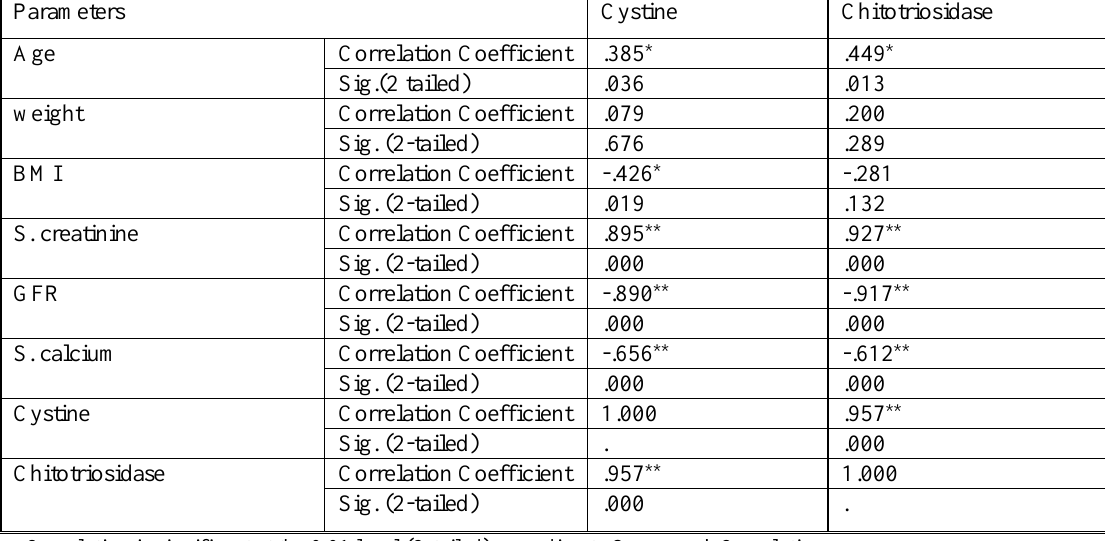
** Correlation is significant at the 0.01 level (2-tailed) according to Spearman's Correlation. * Correlation is significant at the 0.05 level (2-tailed). Patient